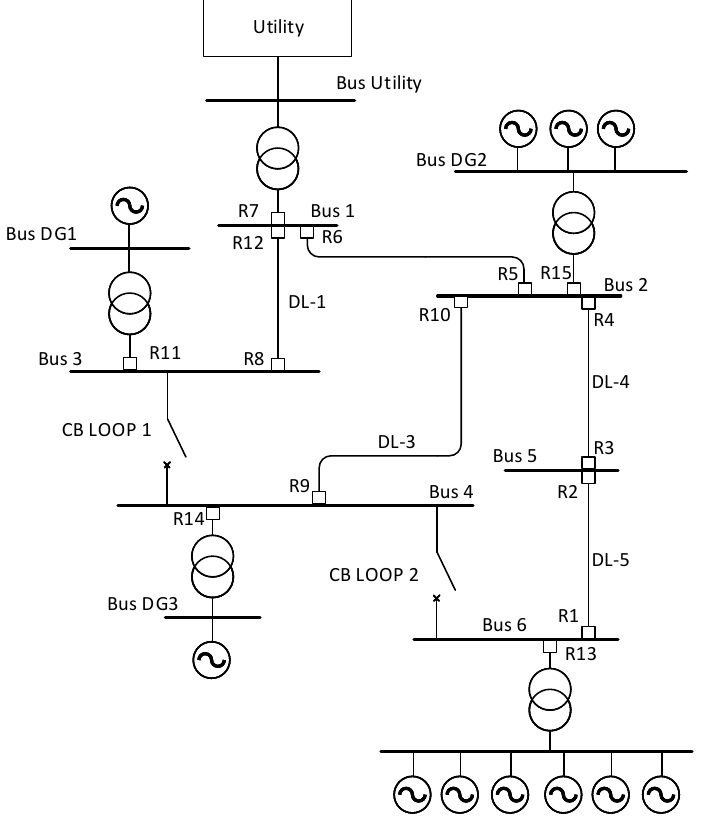
Figure 3. Benchmark IEC MG.